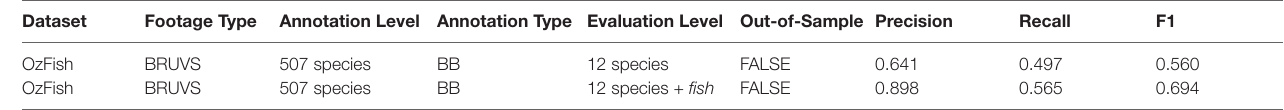
TABLE 3 | Summary of the datasets used for evaluating the species classification performance on the OzFish test data.